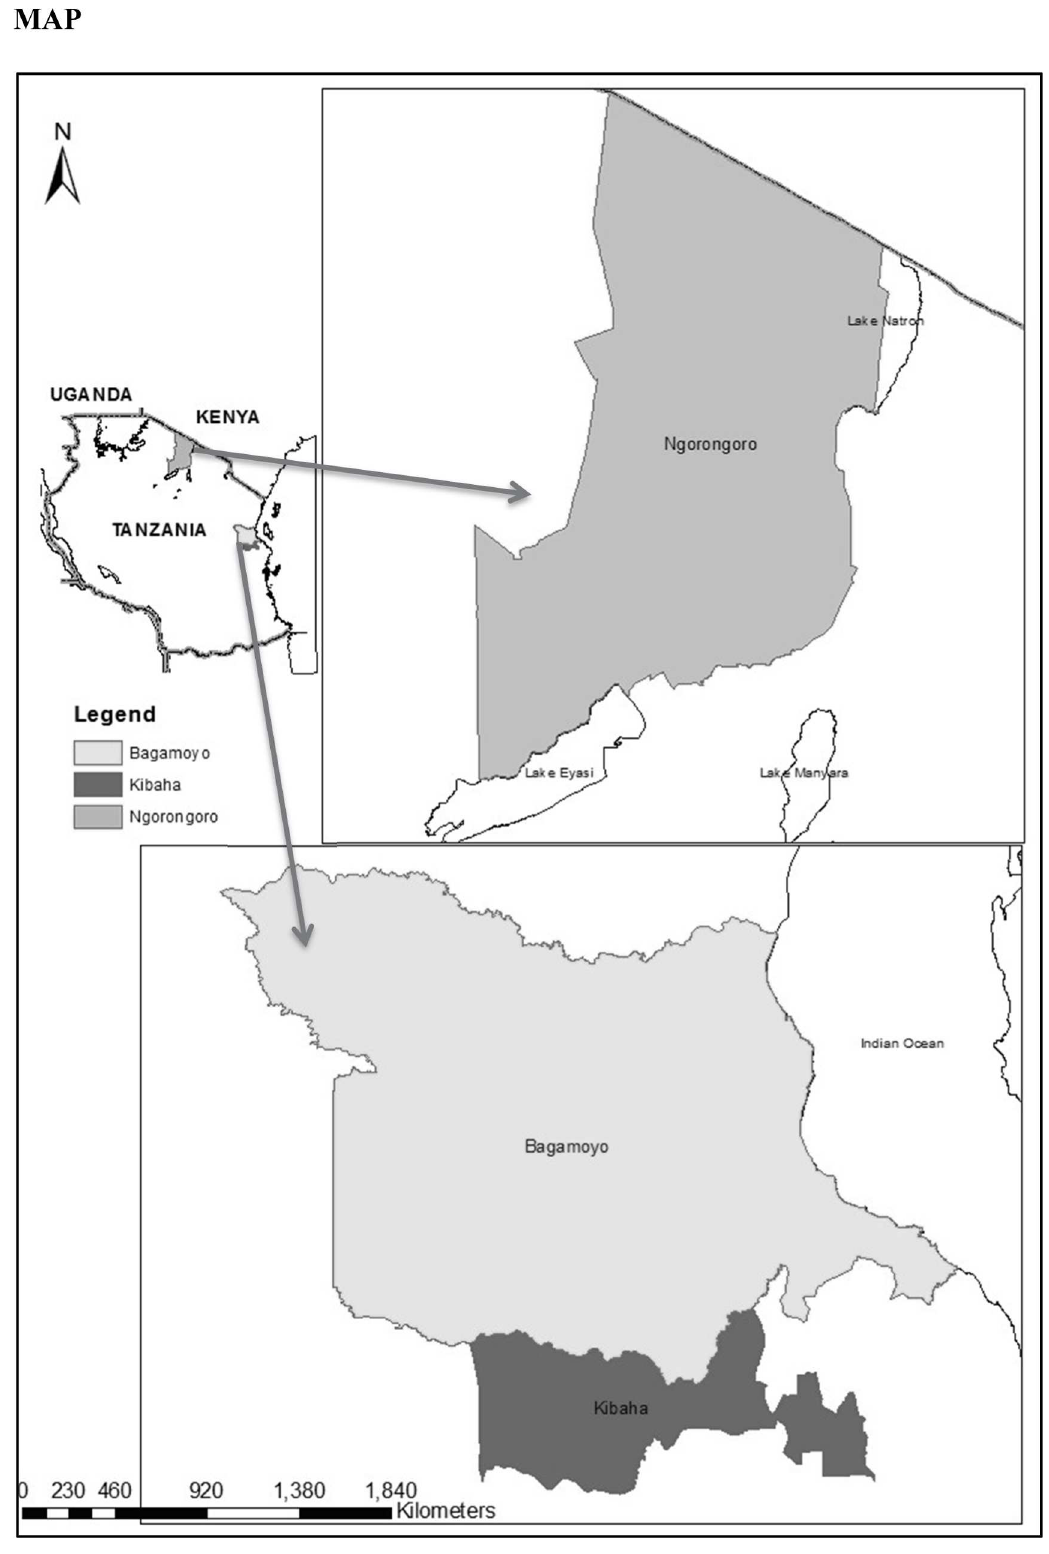
Fig 1. Study sites